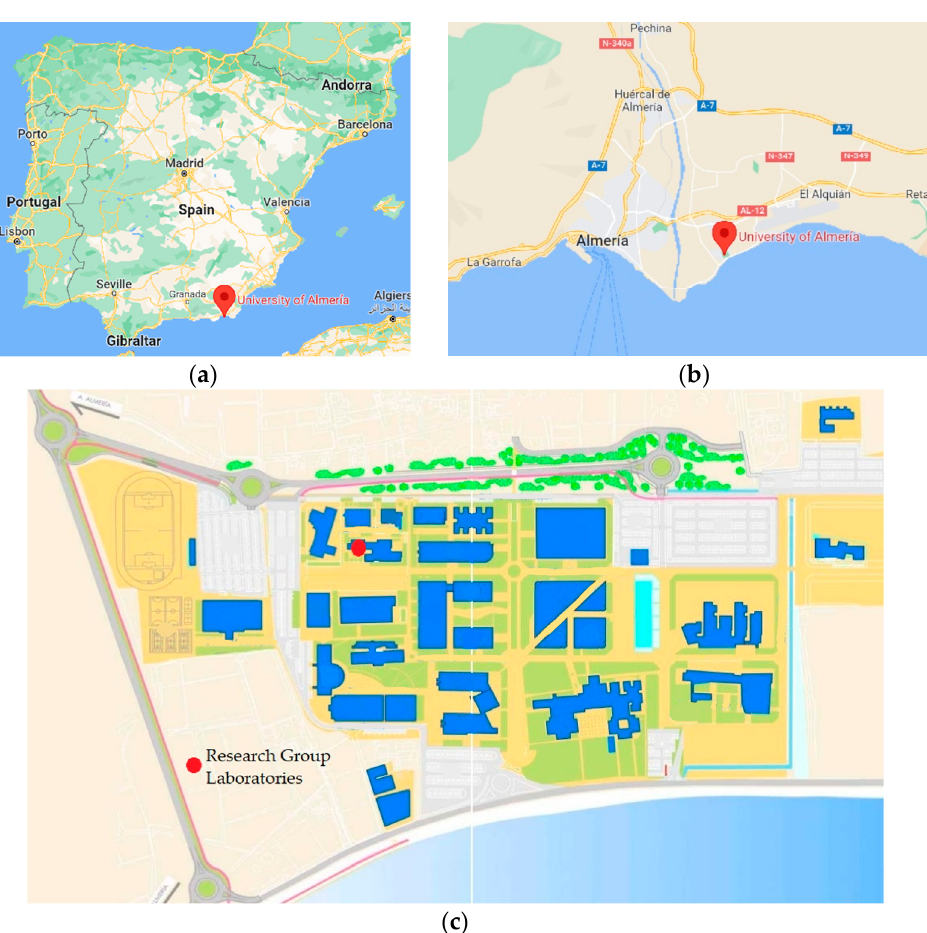
Figure 3. Location of the ELF magnetometer. ( a ) Almeria location; ( b ) UAL location; ( c ) Laboratory location inside the UAL